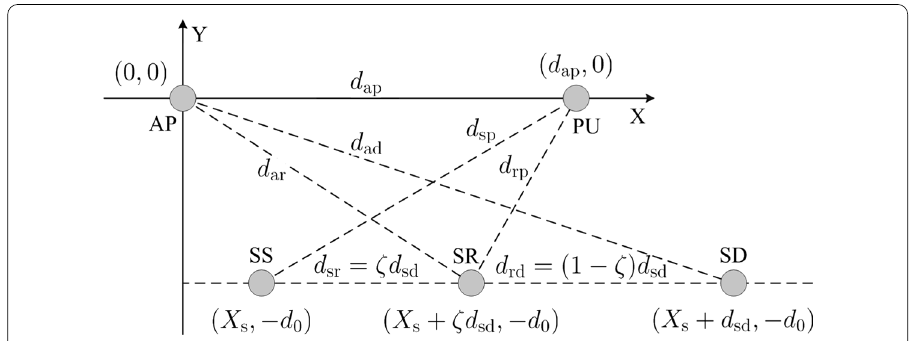
Fig. 2 Relative locations between primary and secondary